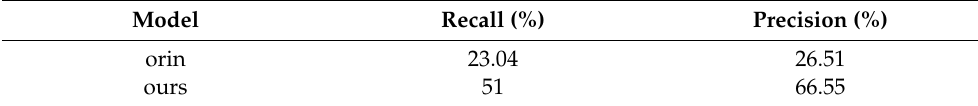
Table 3. Comparison above CarChase2 dataset.